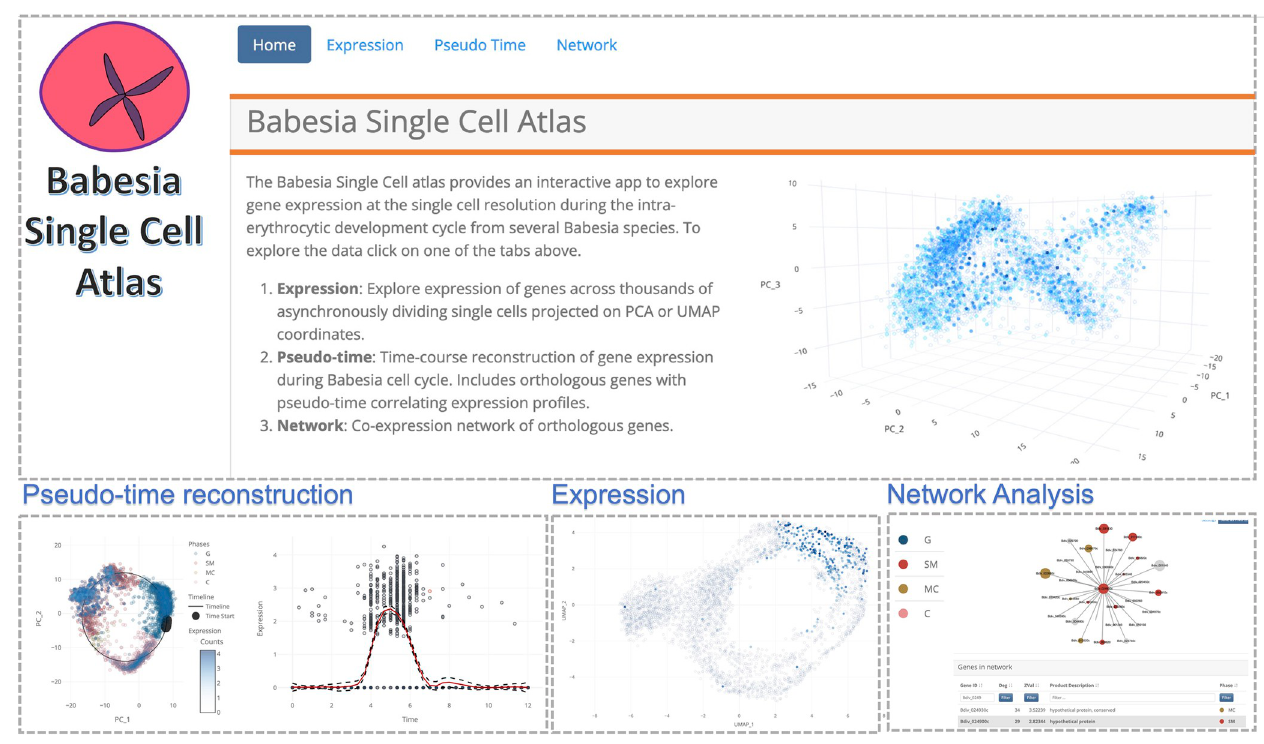
Fig 10. Babesia single-cell atlas screenshots. The app provides functionality for pseudo-time analysis, visualizing expression, network analysis, and comparative transcriptomics. URL: https://umbibio.math.umb.edu/babesiasc/. Data and code for generating the figure are available at https://github.com/